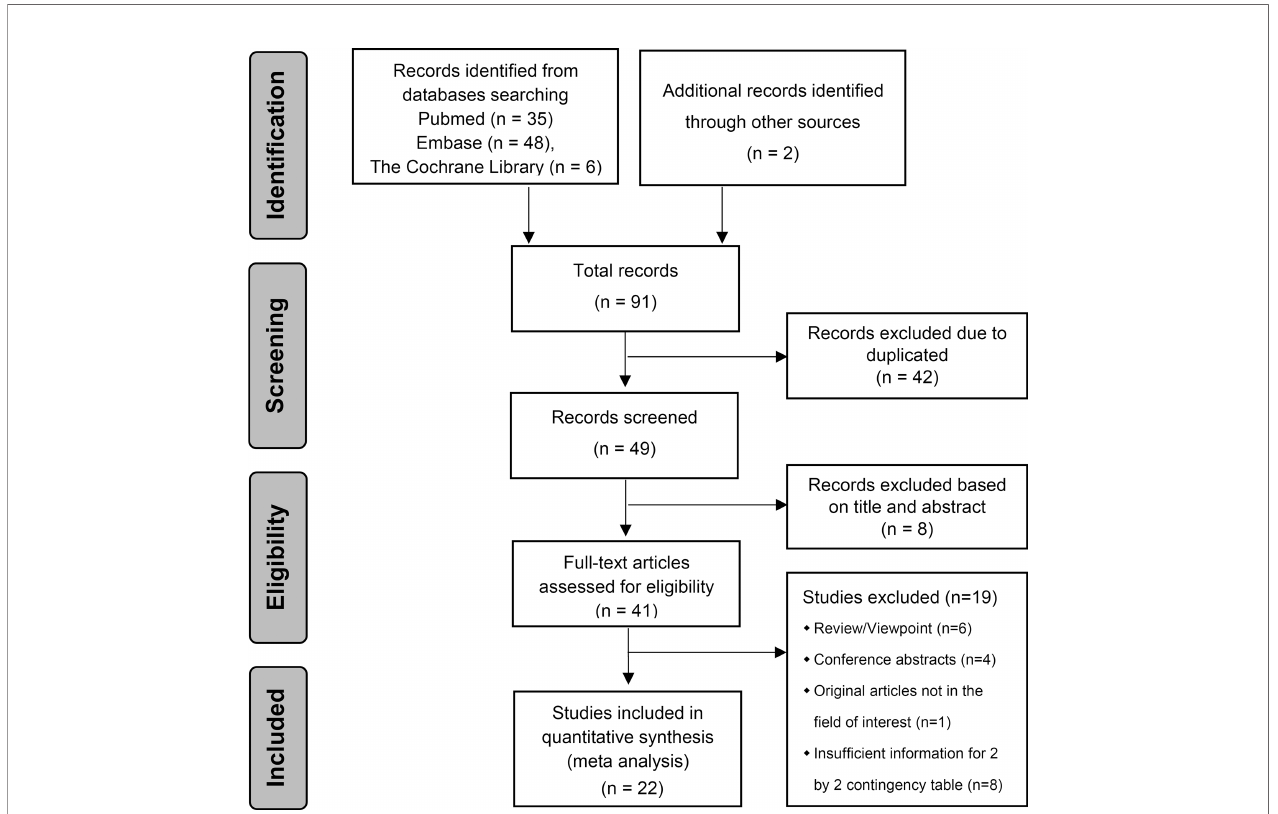
FIGURE 1 | PRISMA fl owchart of the study selection